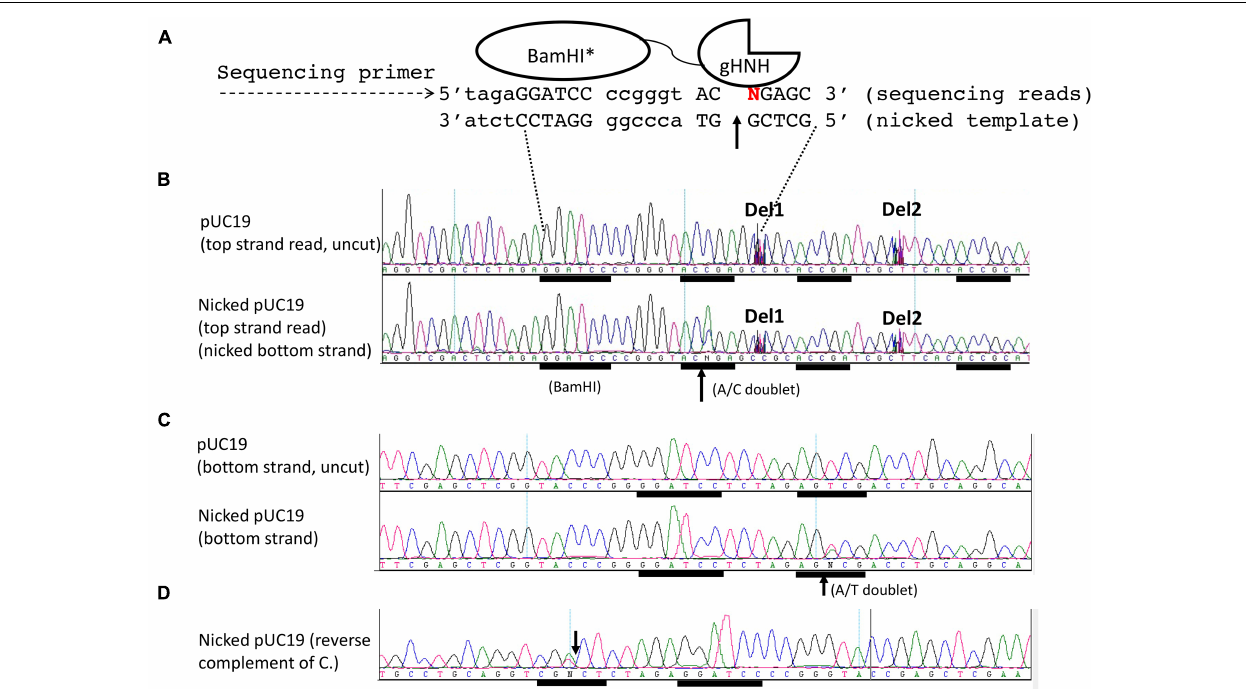
FIGURE 3 | DNA run-off sequencing to map the nicking site(s) and nicking distance from a Bam HI site in pUC19. The plasmid substrate was digested by the fusion nickase at 37 ◦ C for 30 min in NEB buffer 2 supplemented with 1 mM MnCl 2 . (A) The composite nicking site GGATCC-N6-AC ↑ CGA is shown in a schematic diagram. (B) Top-strand sequencing read from the nicked bottom strand. The up arrow indicates the bottom strand of AC ↑ CGA was nicked and the appearance of an extra adenine (A) peak in the doublet as “A/C.” The addition of an extra peak “A” was catalyzed by the Taq DNA polymerase (template-independent terminal nucleotide transferase) when the template DNA is broken (nicked). Del1 and Del2 indicate some intervening sequences were manually deleted to show the downstream sites (ACCGA and ACCGC). (C) Bottom-strand sequencing read form nicked top-strand DNA. A star nicking site 5 (cid:48) GGATCC N5 AGTCG 3 (cid:48) was detected by the presence of an “A/T” doublet. The same sequence was shown as a reverse-complement in (D) . The down arrow indicates the nicked position.